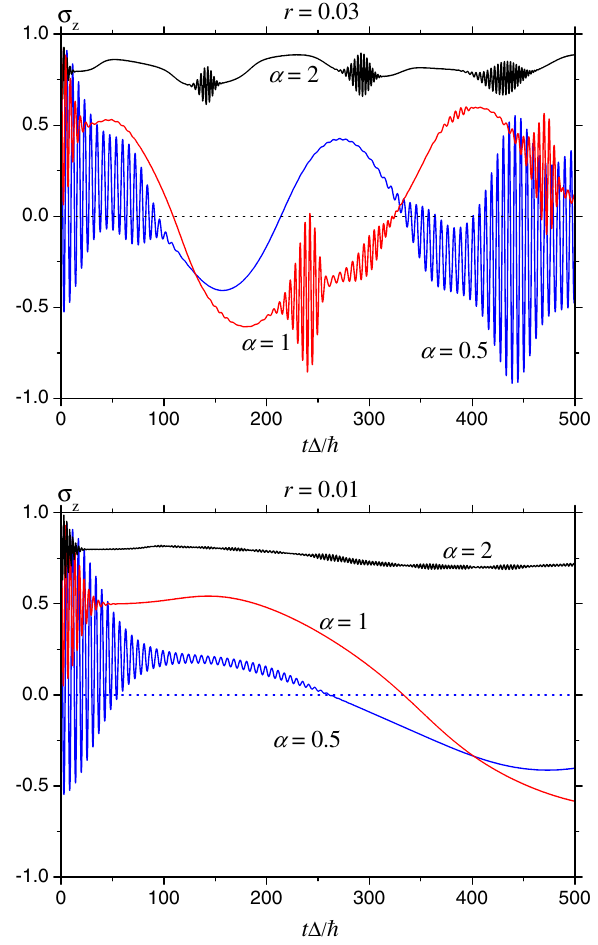
i for r ¼ 0 : 01 , 0.03 and (cid:3) ¼ z t